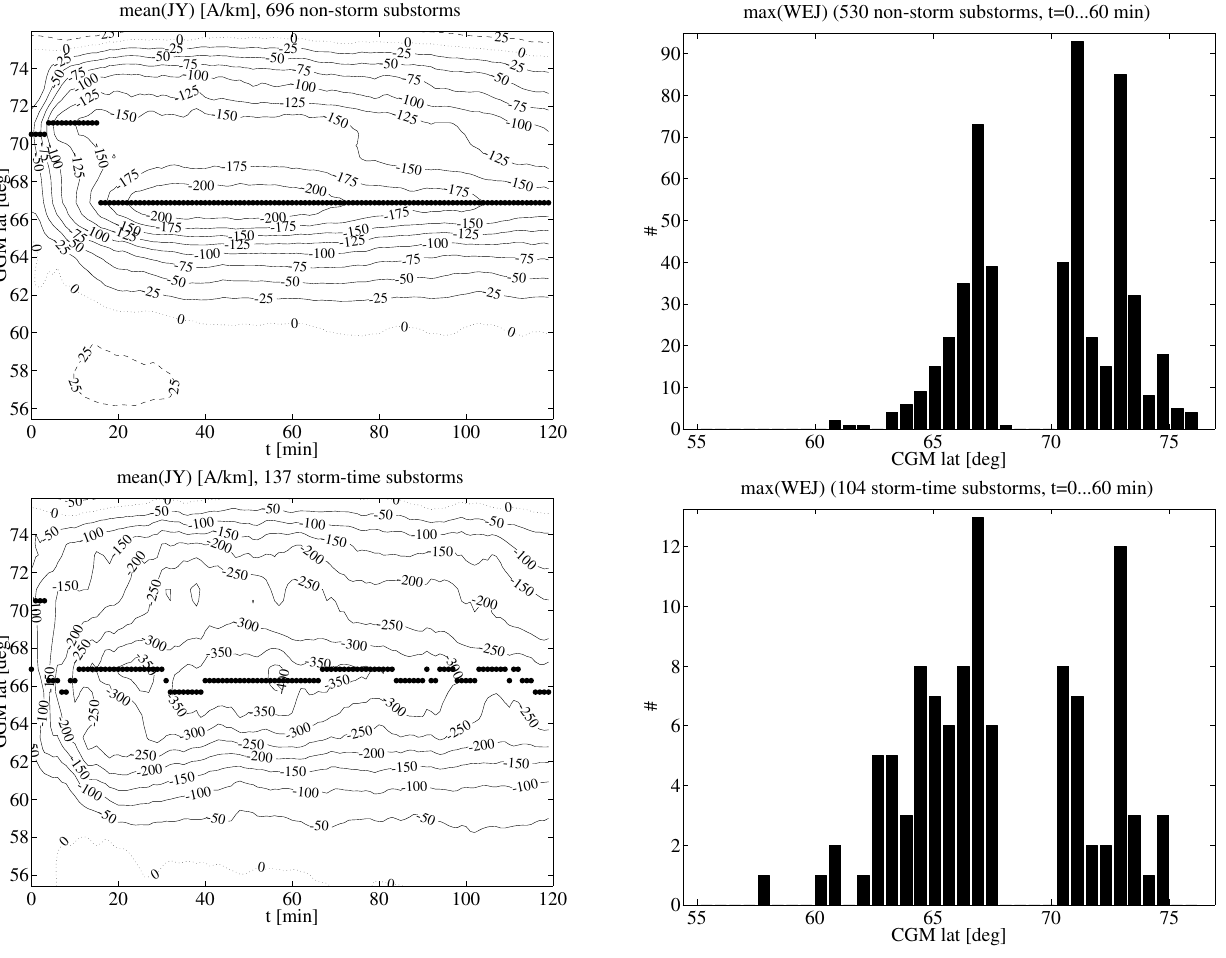
Fig. 11. Average eastward equivalent current density ( JY ) during Fig. 12. Distribution of the latitude of the maximum of the west- 120min after the onset at t = 0. Negative values marked by negative eastward equivalent current density ( JY ) during 120 minutes after the Fig. 11. Average ward equivalent current (WEJ) density at the moment of the maxi- contour lines mean a westward current. Dots show the location of Fig. 12. Distribution of the latitude of the maximum of the westward equivalent current mum d H /dt . Only timesteps within 60min after the onset are taken the maximum westward current density. Upper panel: non-storm onset at t = 0 . Negative values marked by negative contour lines mean a westward current. into substorms, lower panel: storm-time substorms. (WEJ) density at the moment of the maximum d H /dt . Only timesteps within 60 minutes Dots show the location of the maximum westward current density. Upper panel: non-storm after the onset are taken into account. substorms, lower panel: storm-time substorms.